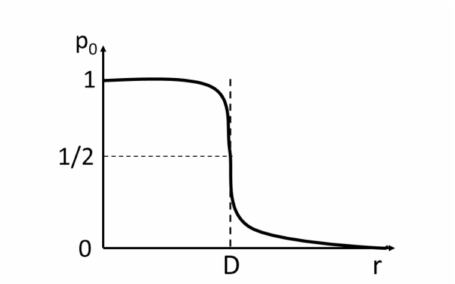
Figure 3. Probability p 0 of the male response to a pheromone trap distance r away. D is the plume